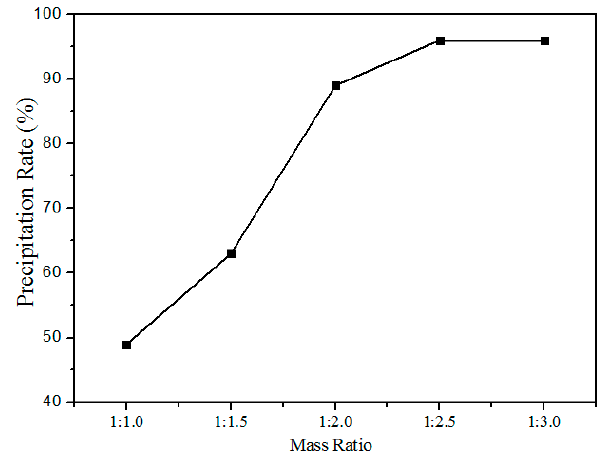
Figure 11. Effect of oxalate addition on the precipitation rate of RE elements.